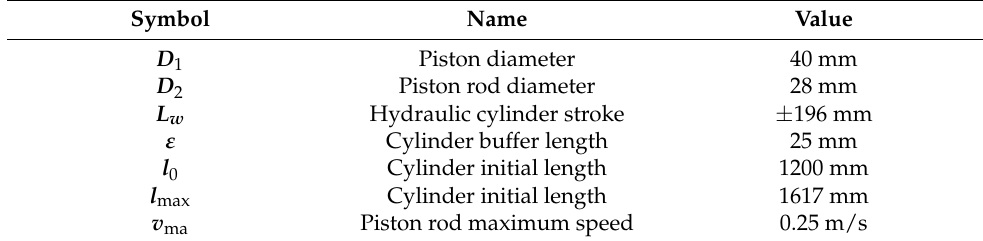
Table 1. Hydraulic cylinder